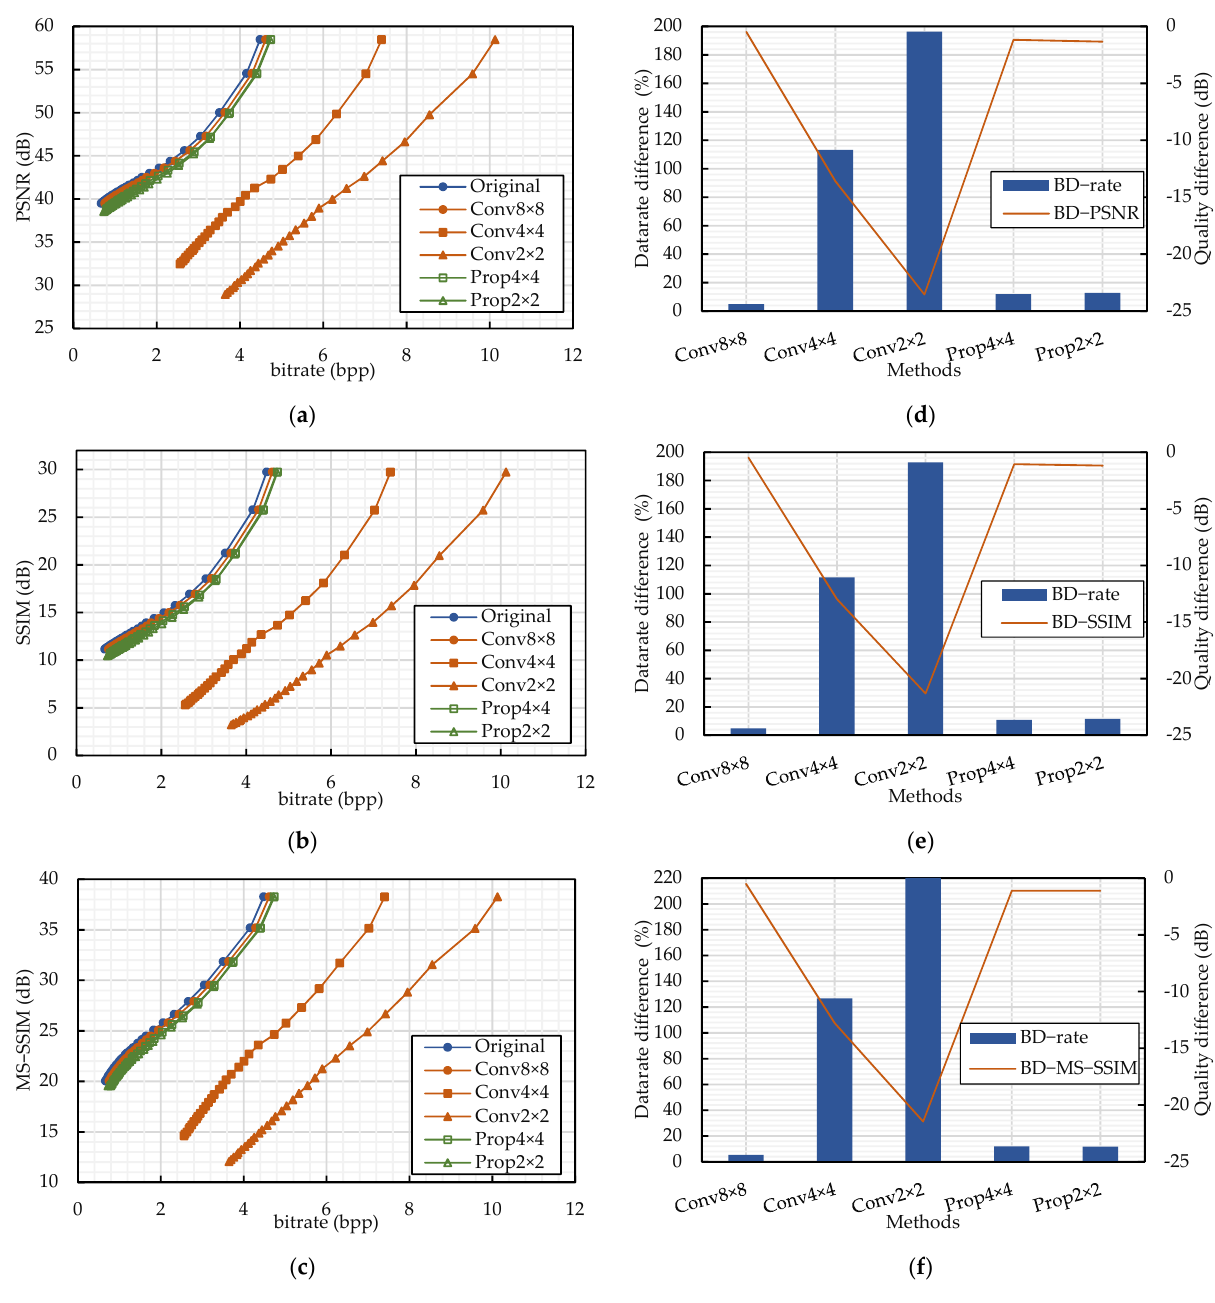
Figure 6. Compression performance analysis of perceptual encryption methods. ( a – c ) shows rate distortion curves for different image quality measures and ( d – f ) show rate savings (Bjøntegaard Delta) relative to JPEG under different image quality measures. Proposed method allows smaller block with acceptable degradation in compression savings.